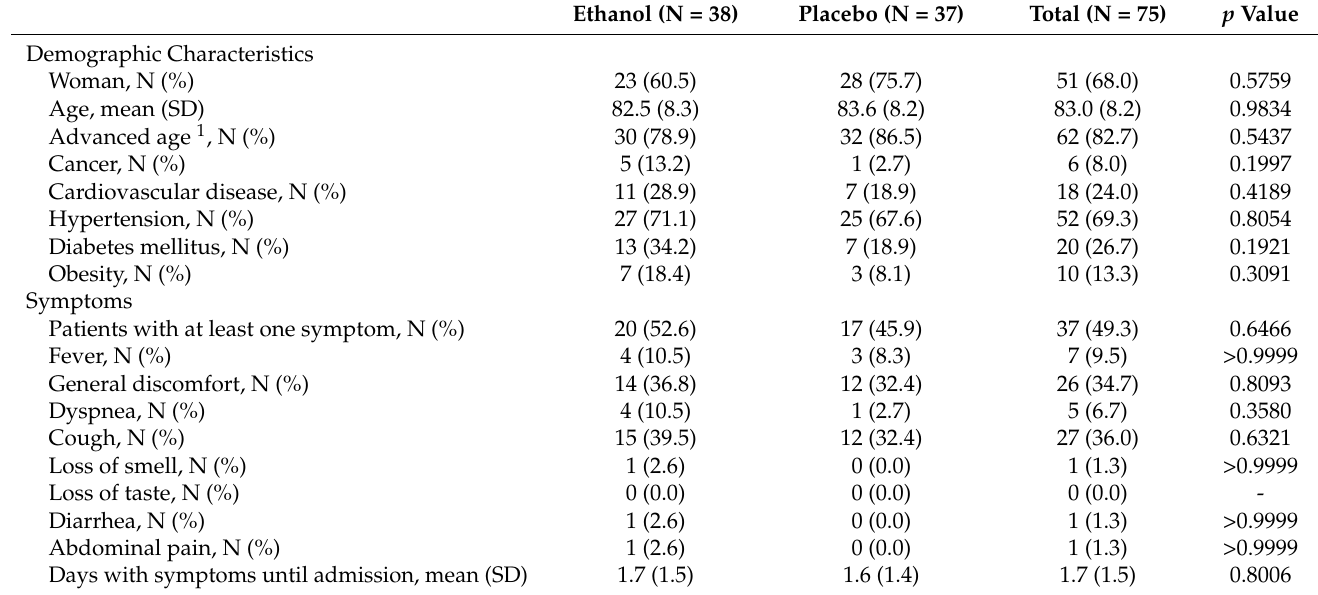
Table 1. Demographic characteristics and risk factors of the intention-to-treat